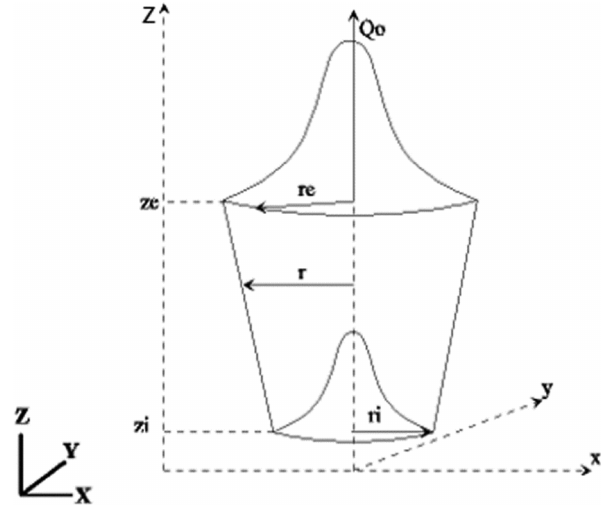
Figure 5: Conical heat